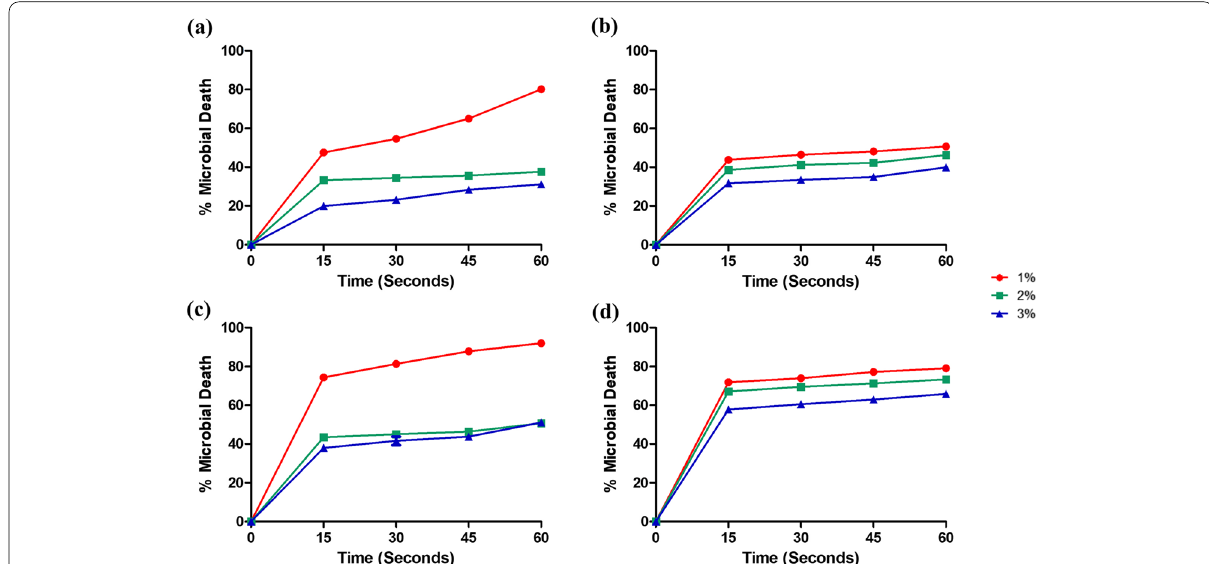
Fig. 4 The effects of carbomer concentration on the percentage microbial death (mean 85% ethanol (ET), S. aureus ; b 85% isopropyl alcohol (IPA), S. aureus ; c 85% ethanol (ET), E. coli ; and d 85% isopropyl alcohol (IPA), E. coli . N